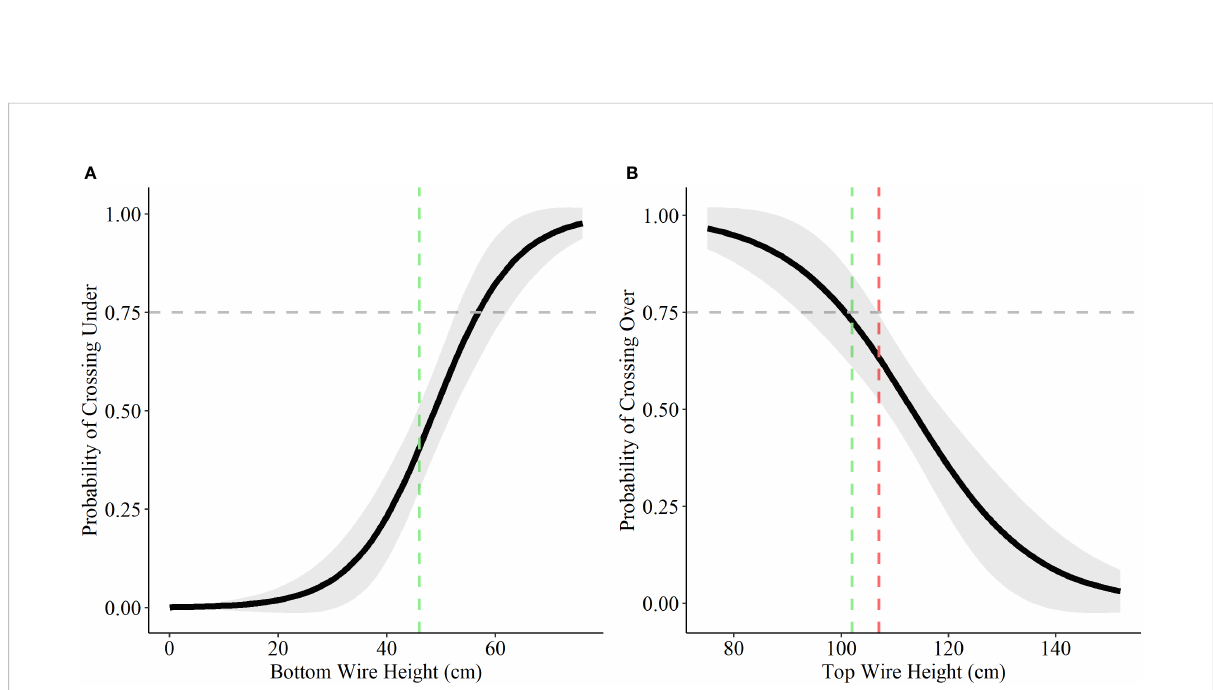
FIGURE 5 Probability of white-tailed deer choosing to cross under (A) and over (B) fences based on a range of bottom and top wire heights. We display the current recommended bottom wire height of 46 cm (18 inches; green) and top wire heights of 102 cm (40 inches; green) and 107 (42 inches; red) as the coloured vertical dashed lines in each graph based on the recommendations for wildlife-friendlier fences (Paige, 2020). The horizontal grey dashed line represents the 75% probability of choosing to cross over or under the